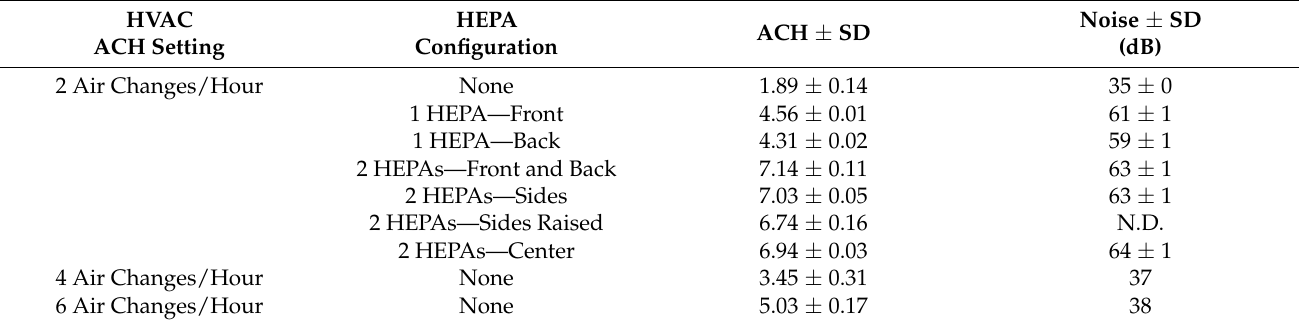
Table 1. Effective air change rates by particle decay and